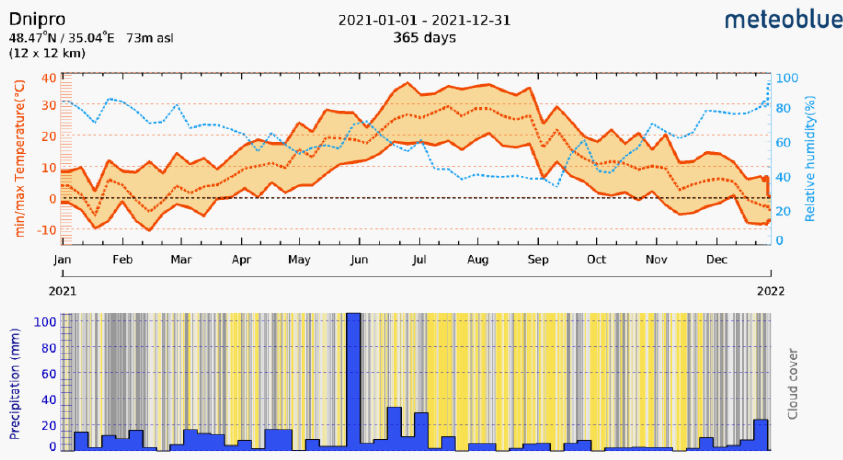
Figure 1. Seasonal changes of climate parameters (www.meteoblue.com; accessed on 28 April 2022) in the territory of Dnipro city.